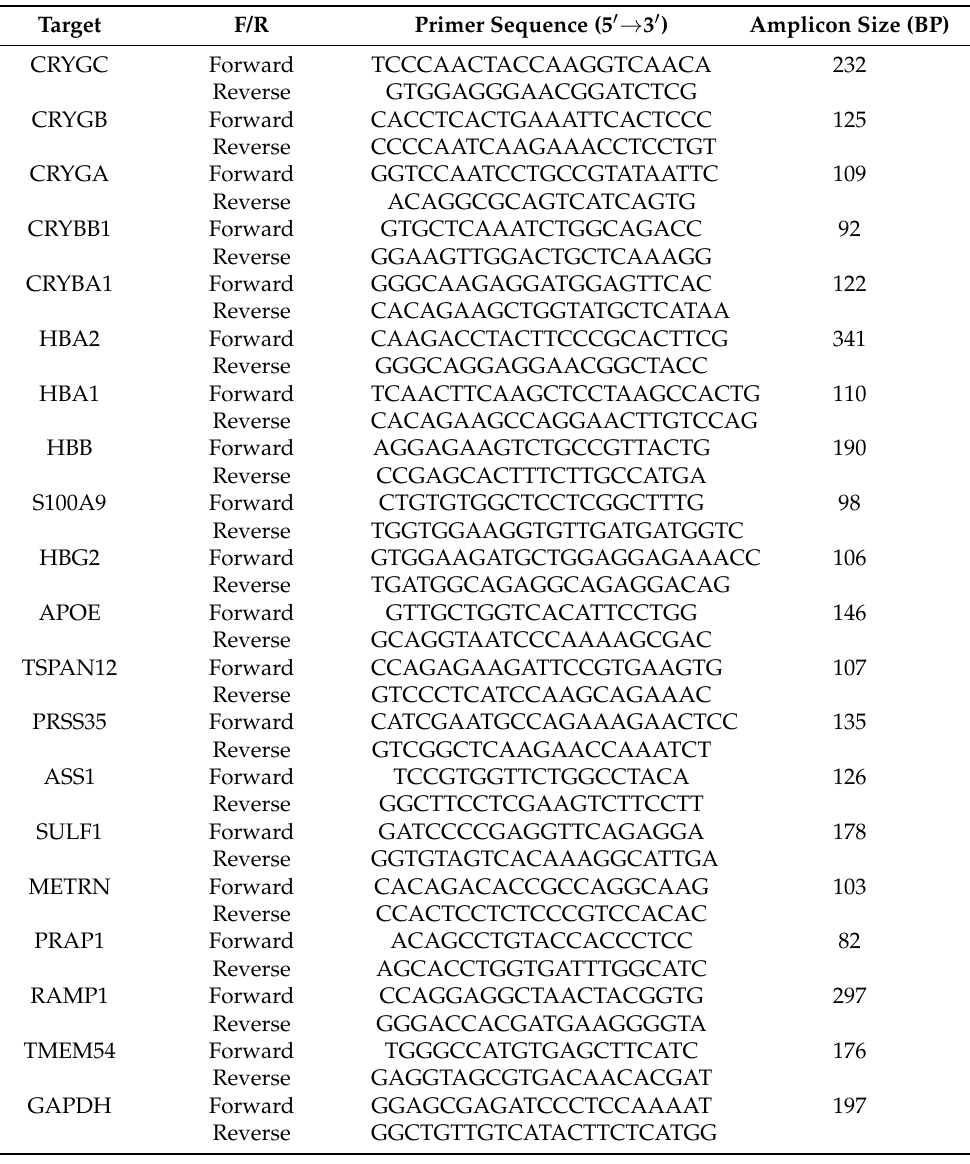
Table 1. Primers for the real-time quantitative PCR (RT-qPCR)